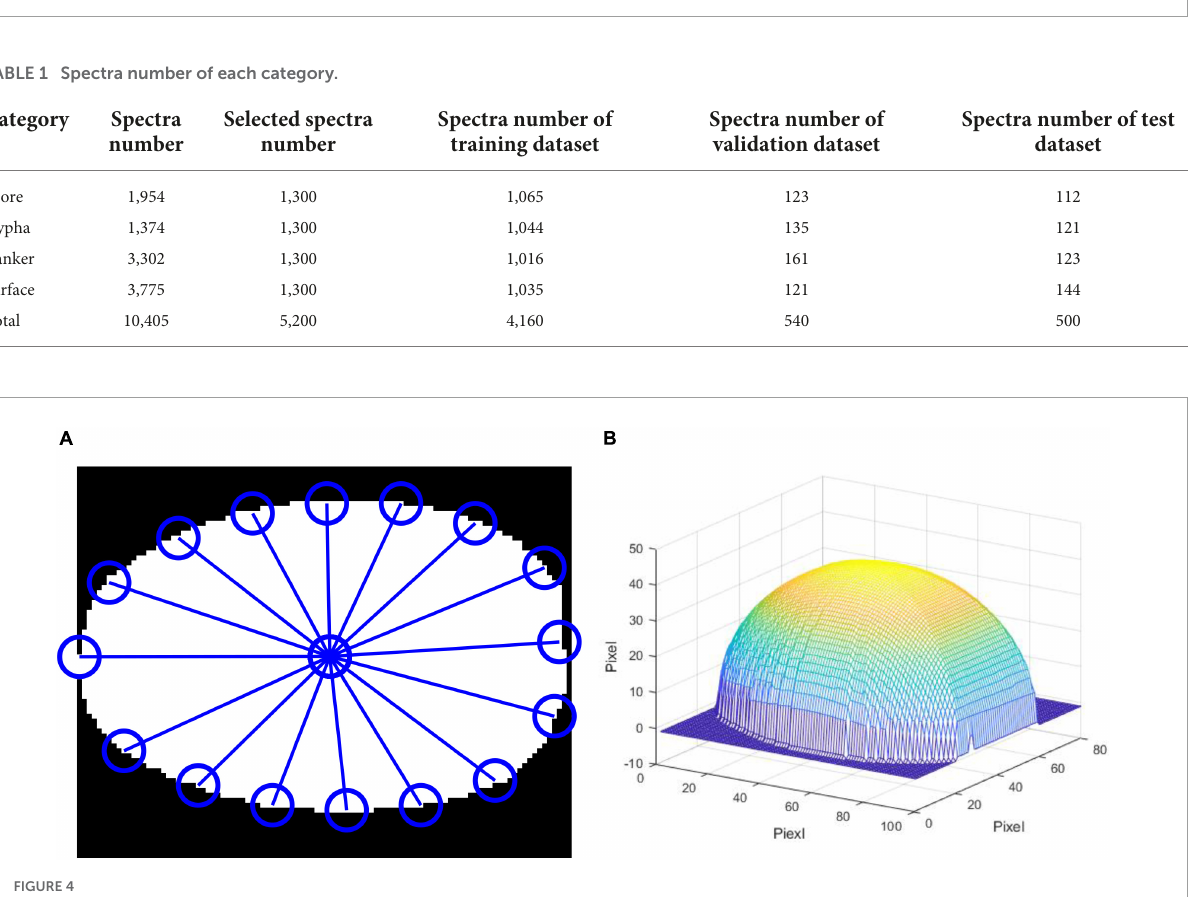
FIGURE3 Reflection spectrum of a normal navel orange surface.